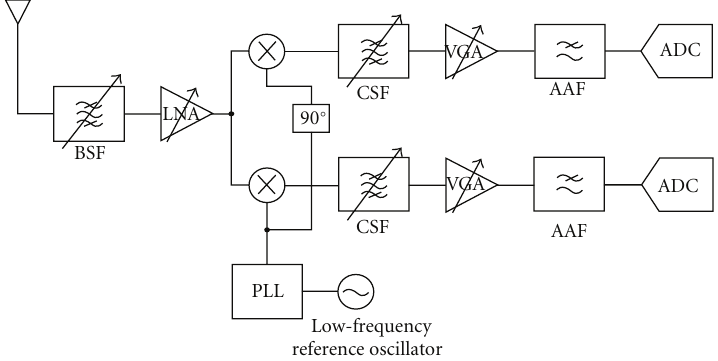
Figure 1: Receiver architecture for each channel (antenna) of our testbed.